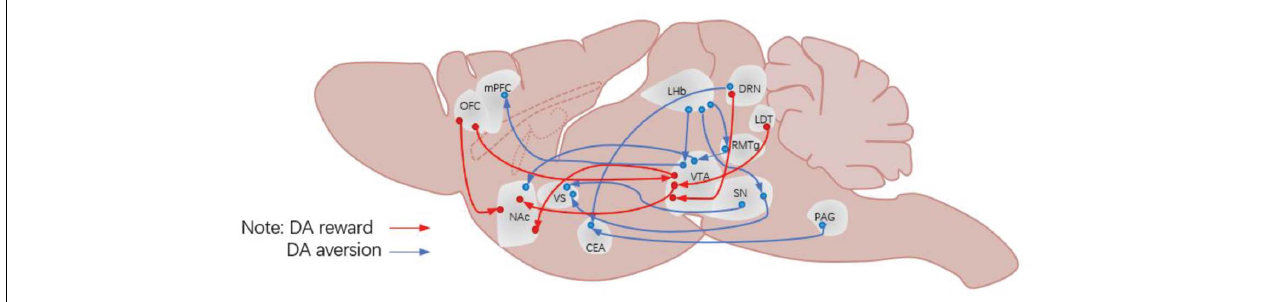
FIGURE 1 | Neural circuits for DA projection. DA, dopamine; OFC, orbitofrontal cortex; mPFC, medial prefrontal cortex; NAc, nucleus accumbens; LHb, lateral habenula; VS, ventral striatum; CEA, central amygdala; VTA, ventral tegmental area; SN, substantia nigra pars compacta; RMTg, rostromedial tegmental nucleus; DRN, dorsal raphe nucleus; PAG, periaqueductal gray matter; LDT, laterodorsal tegmental